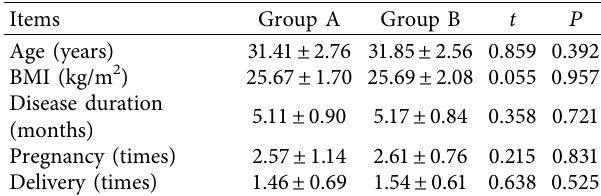
Table 1: Baseline information for groups A and